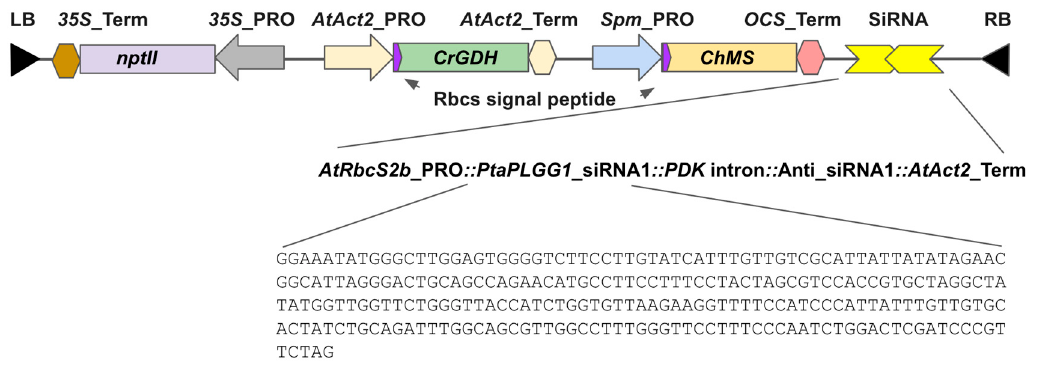
Figure 1. Diagram of construct LC0102 design. Genetic elements within the T-DNA borders are shown. At the bottom is the sequence of the sense element of the 256 bp siRNA1 design targeting the region of PtaPLGG1 transcript from nucleotide position 886 to 1142. An intron of the Flaveria trinervia Pyruvate Orthophosphate Dikinase (PDK) was utilized to separate the sense element and the antisense element of siRNA1. Expression of the siRNAi is under the control of the Arabidopsis thaliana RbcS2b promoter and the 3 ′ terminator of the Arabidopsis Act2 gene. Hybrid poplar INRA 717-1B4 is a hybrid clone of P. tremula × P. alba . In the diploid genome of the hybrid, any given locus would be present as one allele from P. alba and one allele from P. tremula . Pta, standing for Populus tremula × alba , is used to distinguish